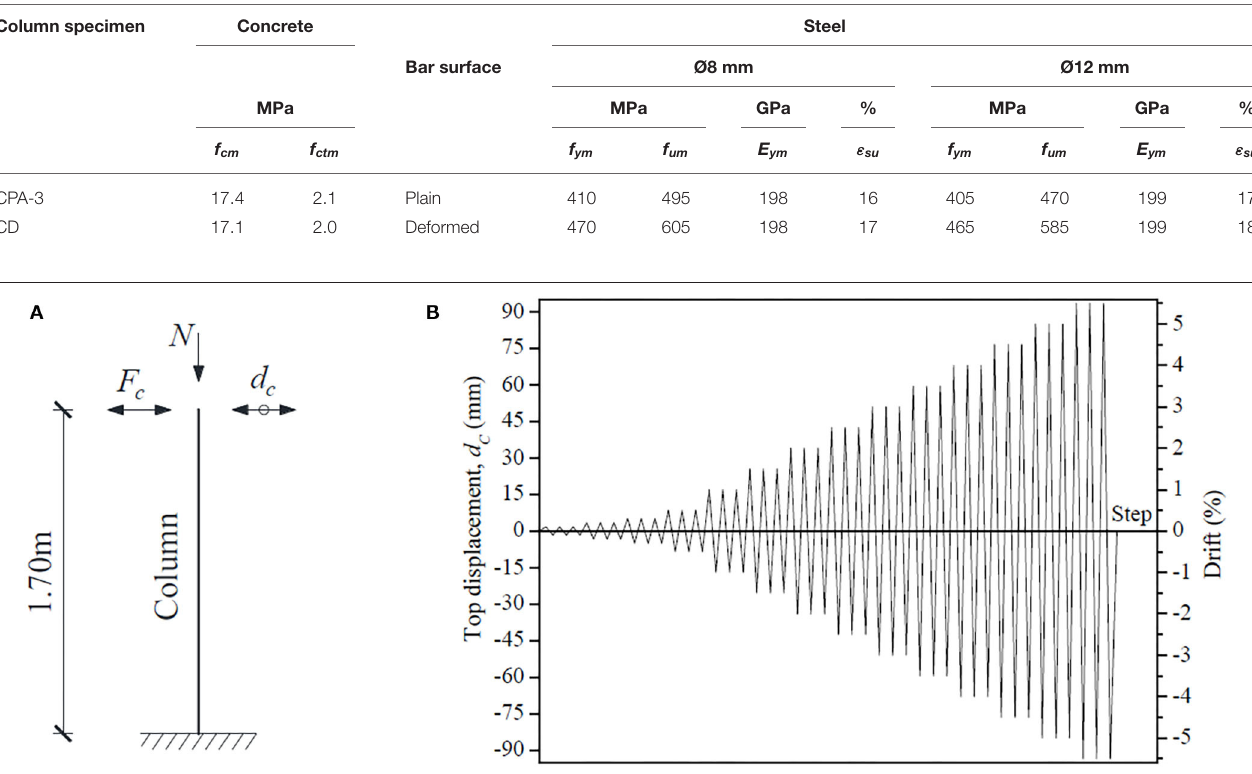
TABLE 1 | Mean mechanical properties of the materials (concrete and steel). Column specimen